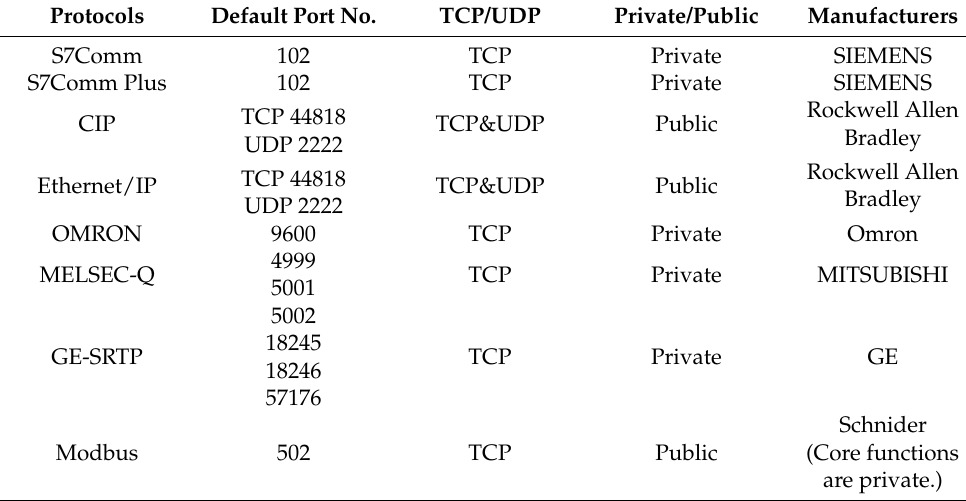
Table 5. Default ports and communication protocols of PLCs.